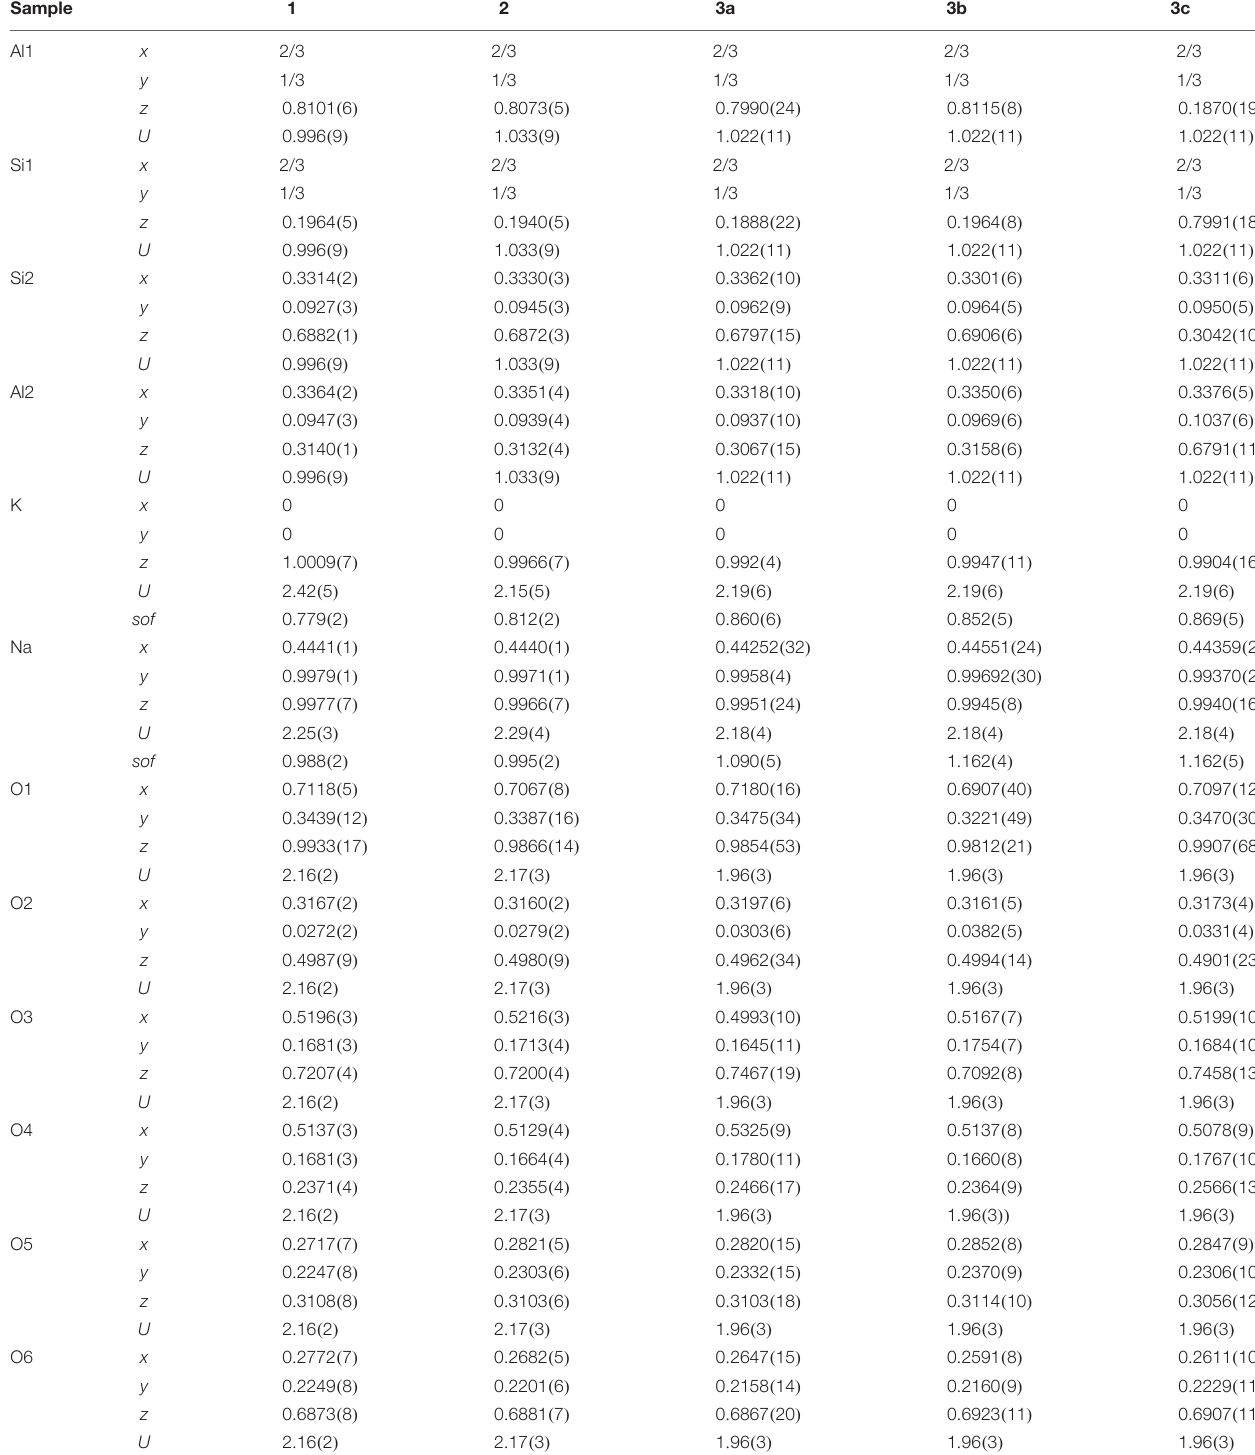
TABLE 3 | Atom coordinates and U Parameters (x 100 Å 2 ) for three nepheline samples.